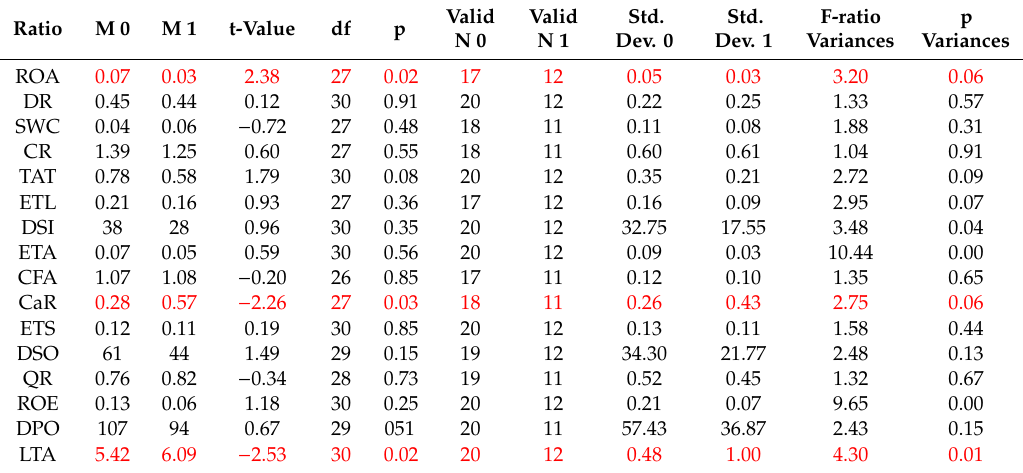
Table A6. The student’s t-test results for the chosen ratios for green (1) and red (0) companies for 2012.